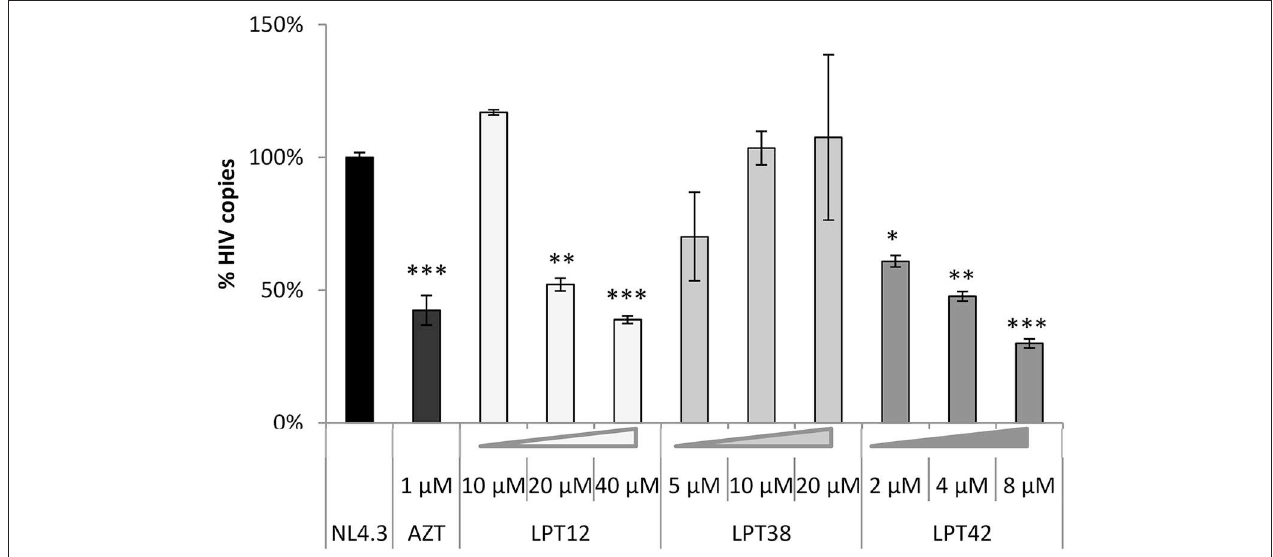
FIGURE 3 | LPTs activity on HIV-1 reverse transcription. Analysis by qPCR of late reverse transcripts in MT-2 cells treated with LPT12 (10, 20, and 40 µ M), LPT38 (5, 10, and 20 µ M), and LPT42 (2, 4, and 8 µ M) and infected with NL4.3 wild type HIV-1 (HIV-1). Results are shown as % of HIV-1 cell copies using 8E5 cells as a reference of the number of HIV-1 copies in cell culture. The untreated control represents the maximum of HIV-1 copies detected (100%). ANOVA analysis was performed to determine the value of p (* p < 0.05, ** p < 0.01,*** p < 0.001) and NL4.3 (untreated HIV-1 infection) was used as control.